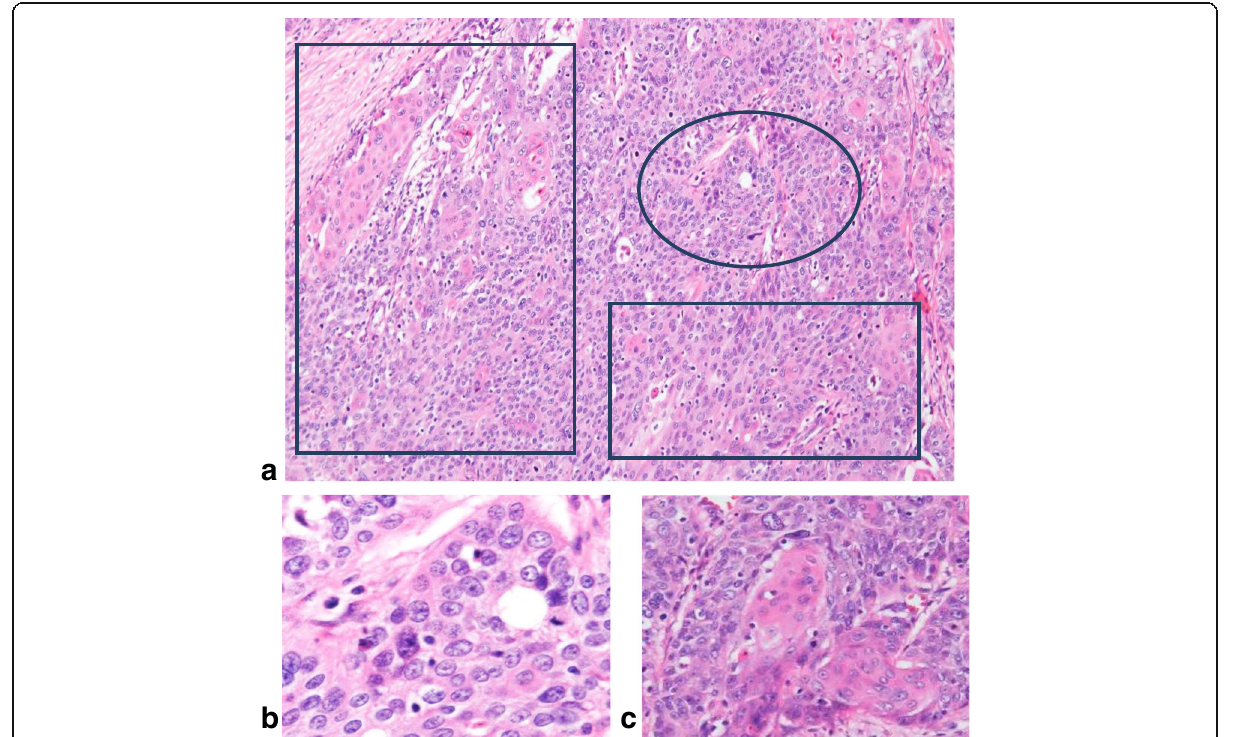
Fig. 5 a Histological findings of the specimen reveal that the adenocarcinoma component (round line) and the squamous cell carcinoma component (square line) are demonstrated. b Tumor cells with enlargements of round nuclei form small ducts and solid pattern (adenocarcinoma component). c Tumor cells form eosinophilic nests, indicating keratinization (squamous cell carcinoma